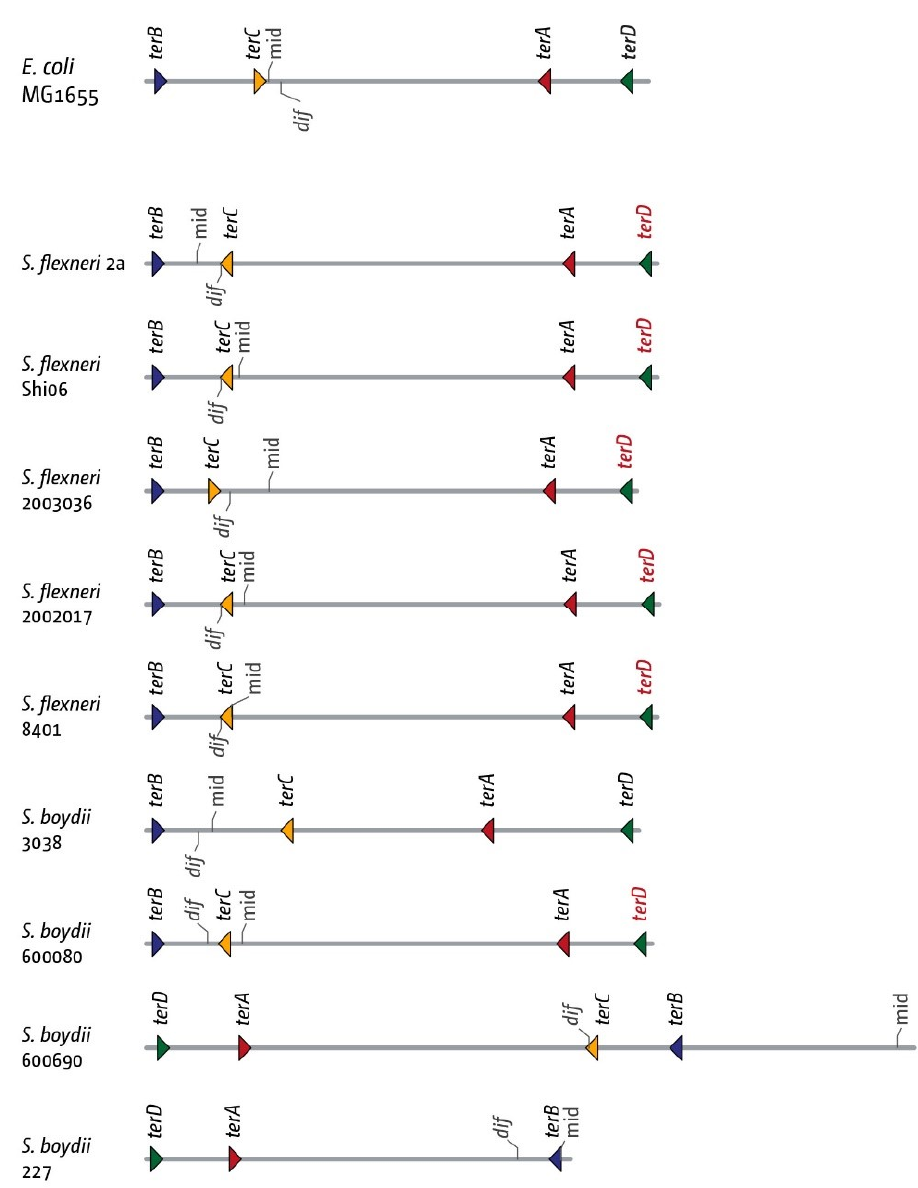
Figure 7. Details of the architecture of the inner replication fork trap in genomes from five Shigella flexneri (serotype S5) and four Shigella boydii (serotype S1) genomes. The inner ter sites A , B , C and D are identified, as well as the chromosome dimer resolution site dif . The orientation of the ter sites are indicated by the direction of the triangle (forks encountering the tip of the triangle would get blocked). The orientation of the dif chromosome dimer resolution site is indicated by the marker pointing upwards (indicating the (+)-strand) or downwards (indicating the ( − )-strand). The terD sites highlighted in red indicate a change in the G6 residue, which will make the ability of this ter site to block a progressing replication fork much less efficient (see Figure S7). As the main focus of the comparison are the relative positions of terA , terC , terB and dif , we have not indicated the number of nucleotide changes in this figure.